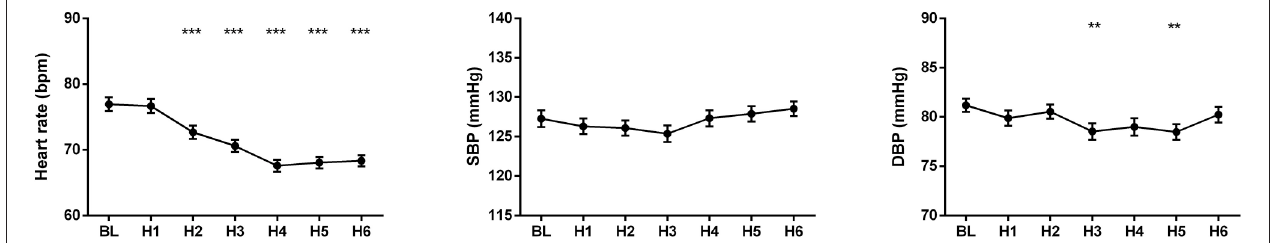
FIGURE 1 | Changes of heart rate and blood pressure after fingolimod administration. BL, baseline; DBP, diastolic blood pressure; H1, H2, H3, H4, H5, H6, the first, second, third, fourth, fifth, and sixth hour after fingolimod intake; SBP, systolic blood pressure. Values are presented as mean ± SEM. ** p < 0.01 compared with baseline, *** p < 0.001 compared with